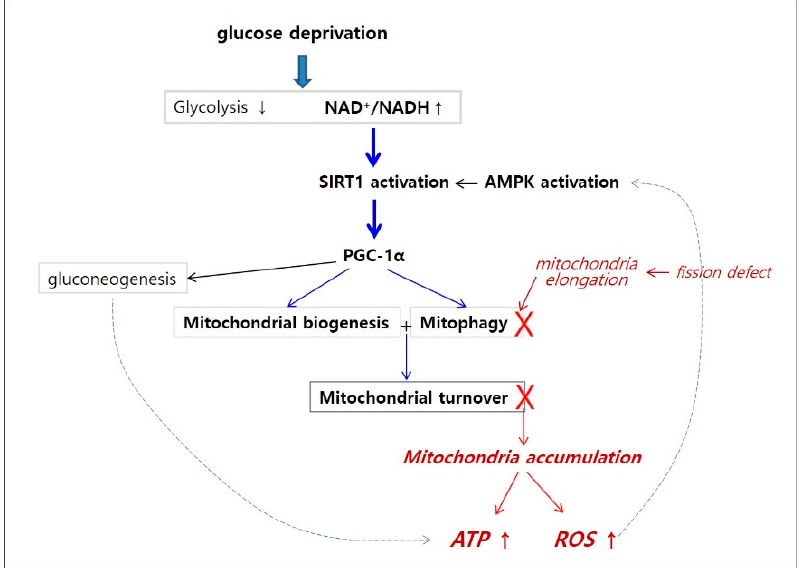
Figure 8. Hypothetical pathway for high-level production of ATP and ROS in glucose-deprived cells. Upon glucose deprivation, glycolysis level decreases causing an elevation in NAD+/NADH ratio in the cytosol, leading to SIRT1 activation. This activates PGC-1 α , which triggers mitochondrial biogenesis and autophagy, and these together promote mitochondrial turnover (a pathway of SIRT1-mitochondrial quality control pathway (blue)). However, defects in mitochondria fission possibly caused by high-level ATP attenuate mitophagy, and induce the accumulation of mitochondria, from which high-level ATP and ROS are generated (a pathway of defective mitophagy (red)). PGC-1 α also increases gluconeogenesis, promoting the increase of glycolysis, which further contributes to the elevation of cellular ATP level.